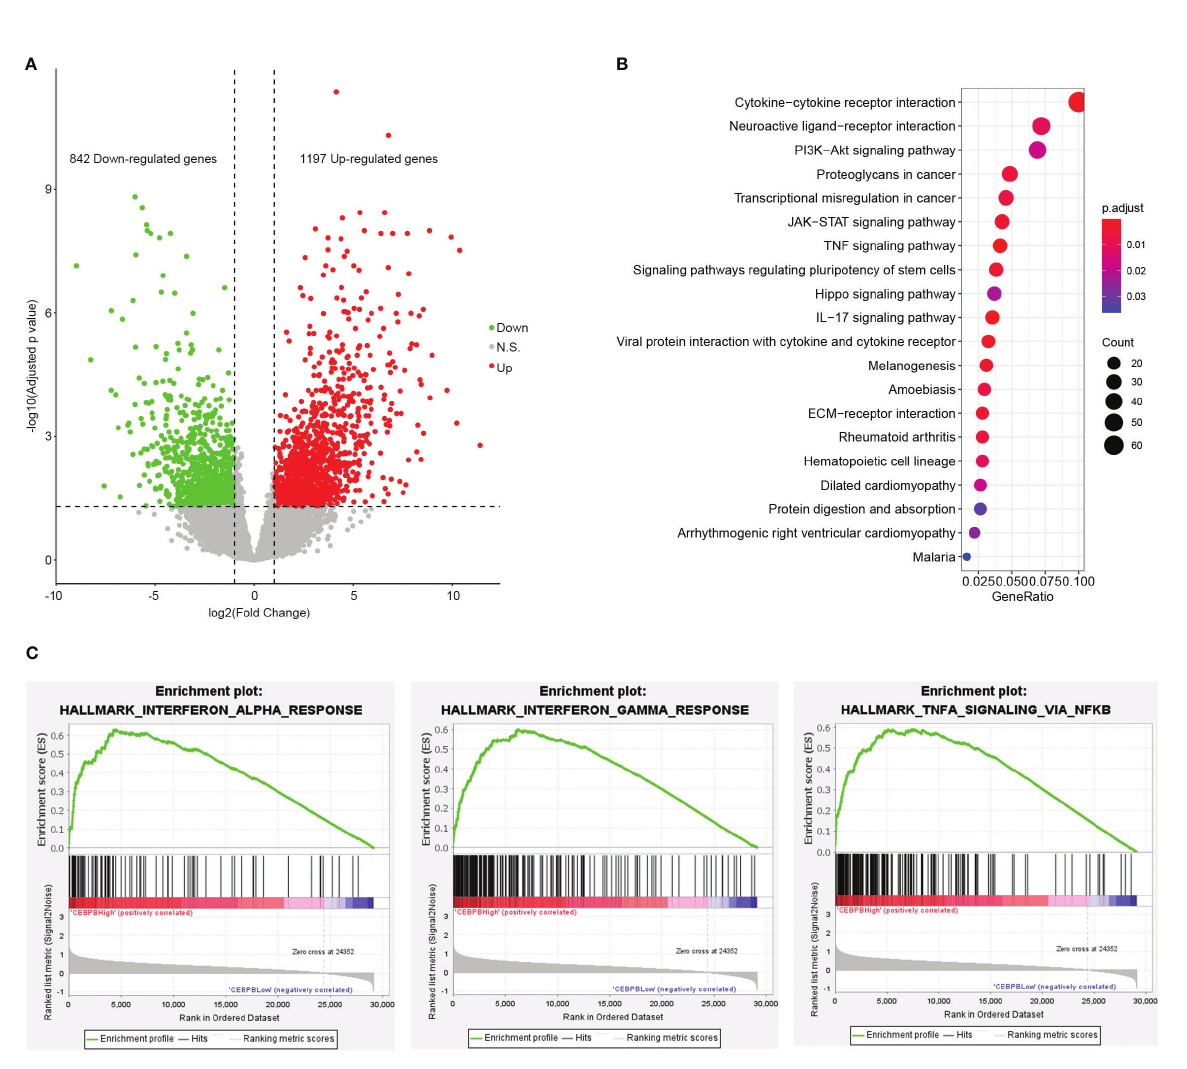
FIGURE 2 CEBPB is closely associated with immune response in metastatic SKCM tumor tissue. (A) Volcano plot of differential expression analysis between the 10 metastatic SKCM patients with the highest CEBPB expression (CEBPB_High) and the 10 with the lowest CEBPB expression (CEBPB_Low) from TCGA-SKCM cohort. Green, red, and gray dots represent signi fi cant downregulated, upregulated, and non-signi fi cant genes in CEBPB_High samples compared with CEBPB_Low samples. x-Axis and y-axis are log2FC and log10-based FDR-adjusted p-value, respectively. (B) The top 20 most signi fi cantly enriched KEGG pathways of the 2,039 DEGs in CEBPB_High samples. Dot size and color illustrate the number of genes included in the corresponding pathway and signi fi cance, respectively. Full list of signi fi cant KEGG pathways is provided in Supplementary Table 1. (C) Enrichment plot of three hallmark gene sets that are signi fi cantly enriched and speci fi cally activated in the CEBPB_High samples compared with CEBPB_Low samples. The full list of signi fi cantly enriched gene sets in CEBPB_High samples is provided in Supplementary Table 2. SKCM, skin cutaneous melanoma; FDR, false discovery rate; KEGG, Kyoto Encyclopedia of Genes and Genomes; DEGs, differentially expressed